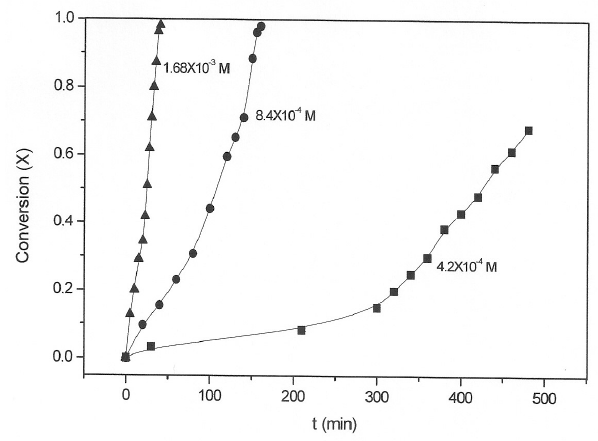
Figure 6. Effect of H 3 O + concentration on thiosulfate transformation: [S 2 O 32 − ] initial , 1 g · L − 1 ; [Cu 2+ ] initial , 0.053 g · L − 1 ; 60 ◦ C; O 2 pressure, 1 atm.